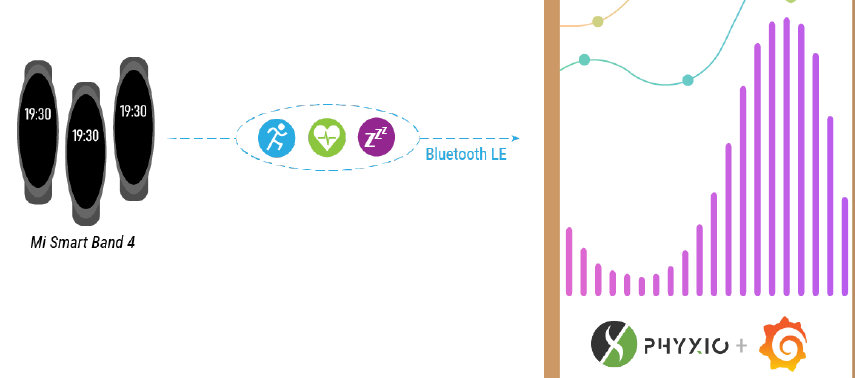
Figure 10. Physical activity monitor.